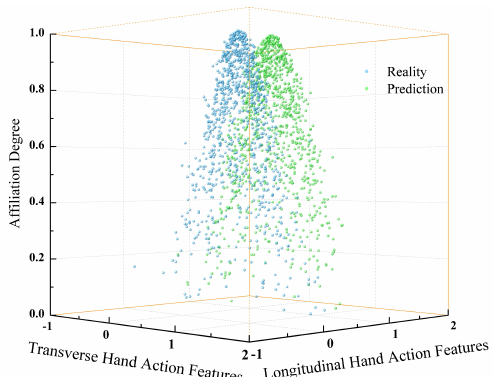
Figure 16. Comparison of cloud models for judgmental segmentation.